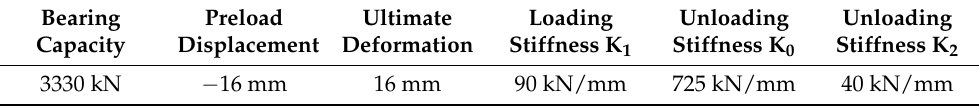
Table 4. New ring spring isolator parameters.